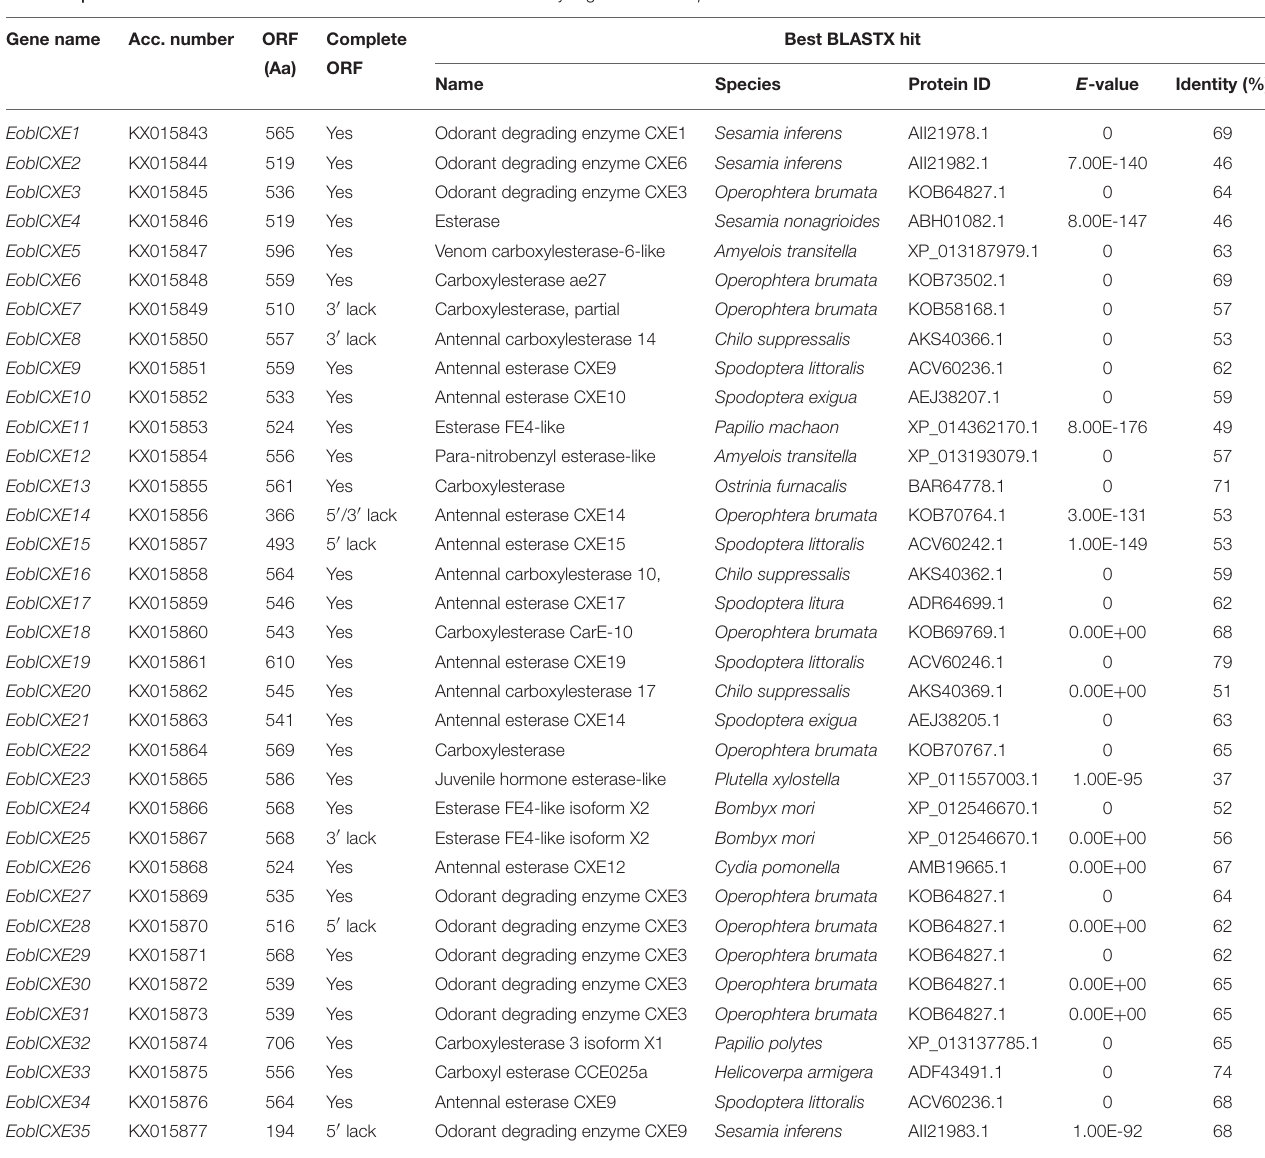
TABLE 1 | BLASTX hits for candidate CXEs identified in the chemosensory organs of E. obliqua